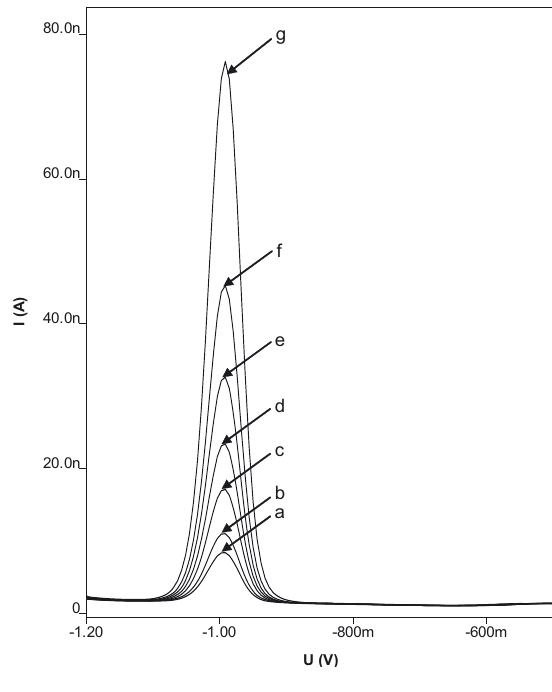
Figure 3. Differential pulse anodic stripping voltammograms of Zn (II) obtained by simultaneous addition of Lu (III). [Lu] (M): 0 (a) , 1.2·10 -9 (b) , 4.9·10 -9 (c) , 9.8·10 -9 (d) , 1.9·10 -8 (e) , 3.7·10 -8 (f) , 7.3·10 -8 (g) . Initial [Zn-EDTA] was